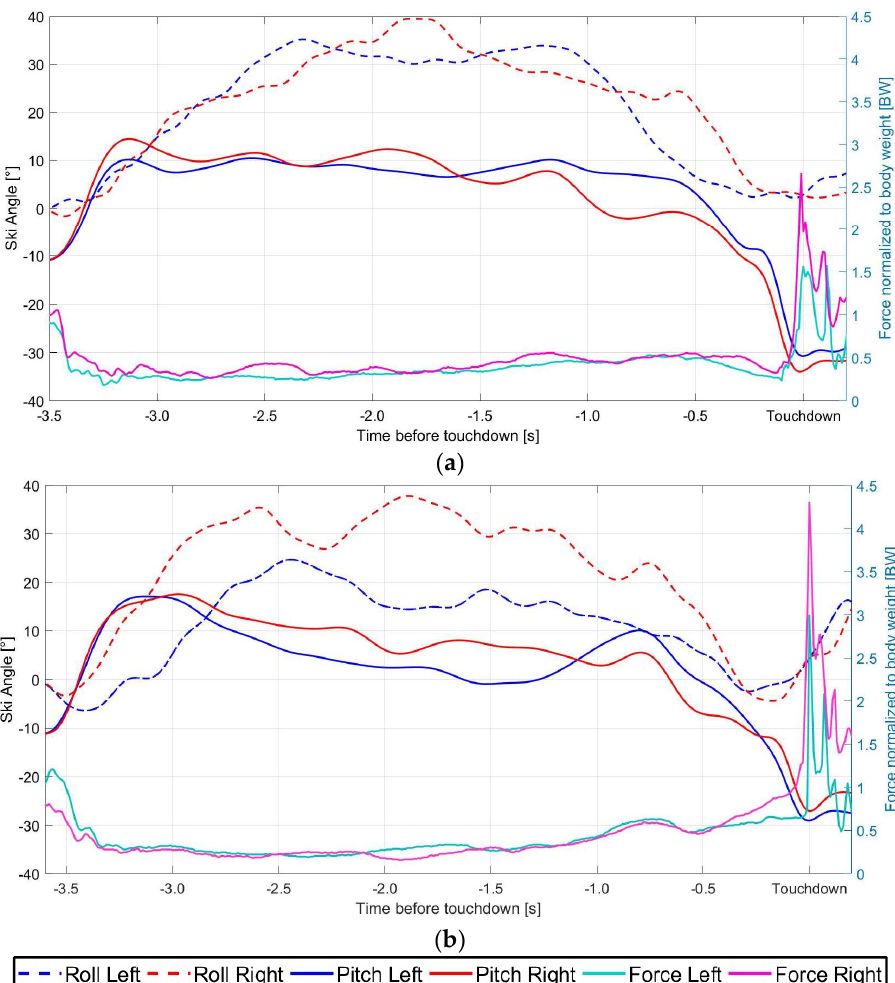
Figure 3. Roll, pitch and overall forces of two jumps characterized by a low (Subject A ( a )) and a high impact (Subject B ( b )) during flight and landing